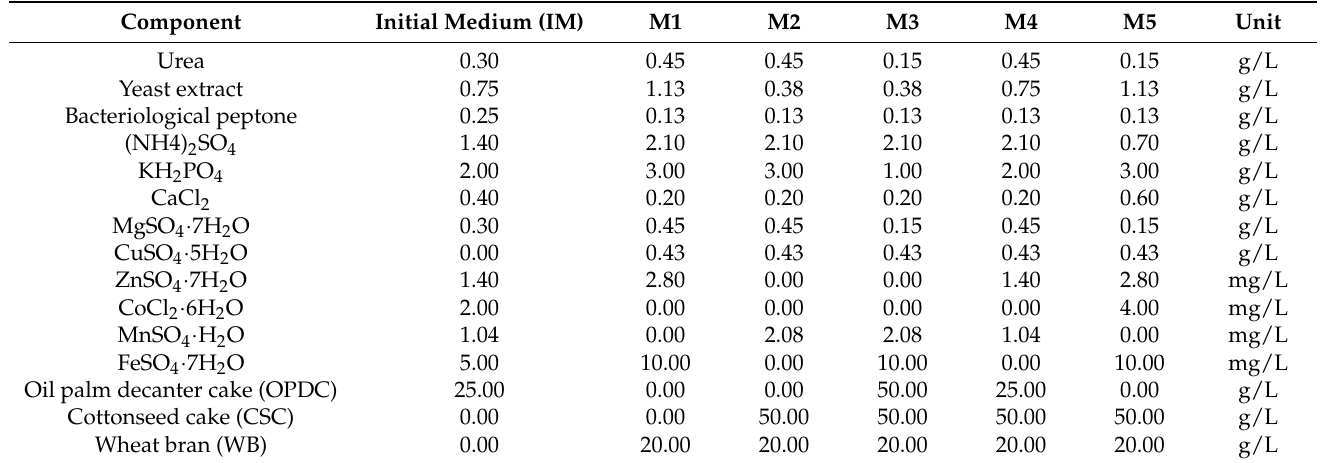
Table 1. Culture media composition for the optimization of enzyme extracts production by monocul- tures and co-cultures of Pl and